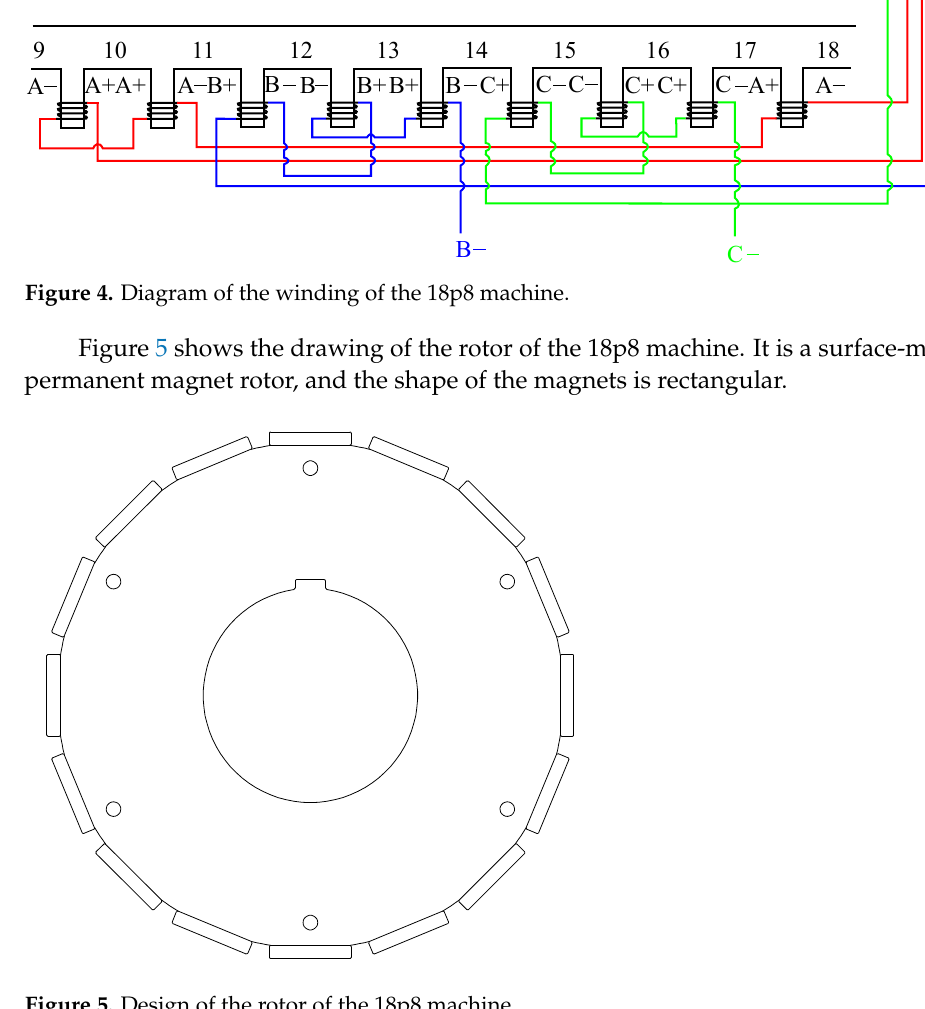
Figure 5. Design of the rotor of the 18p8